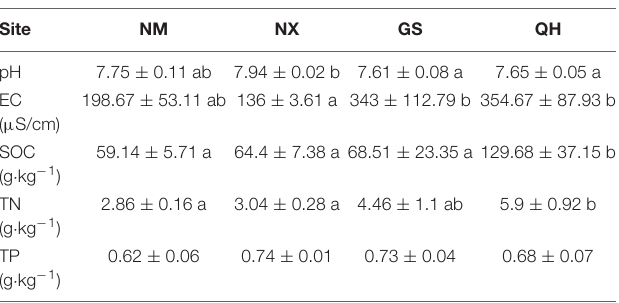
TABLE 1 | Summary of soil characteristics recorded of the study